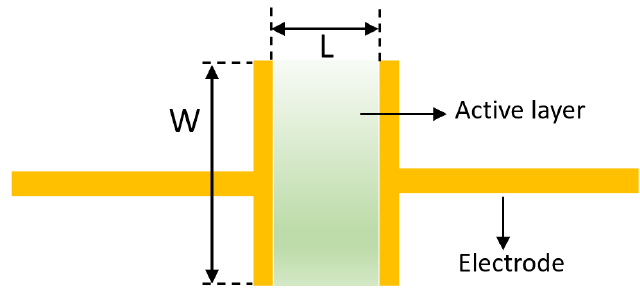
Figure 2. Scheme of source and drain electrodes forming channel with dimensions: W—width; L—length.